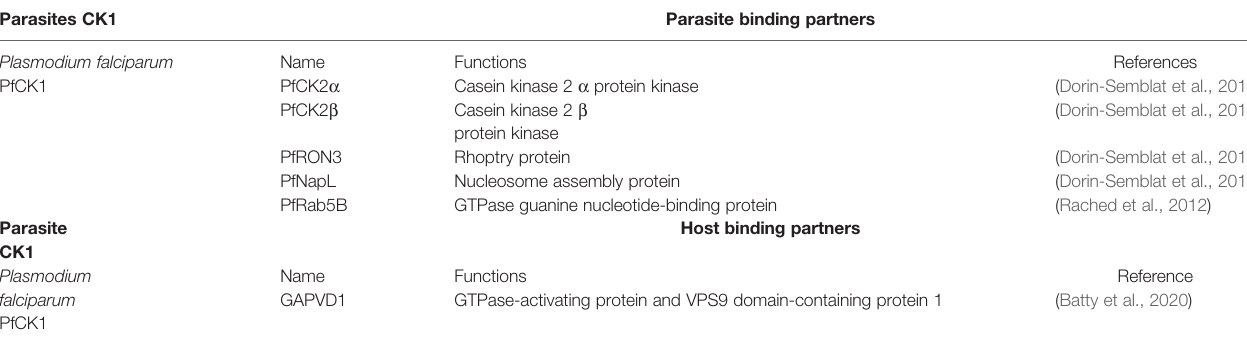
TABLE 3 | Parasitic and host binding partners of parasitic